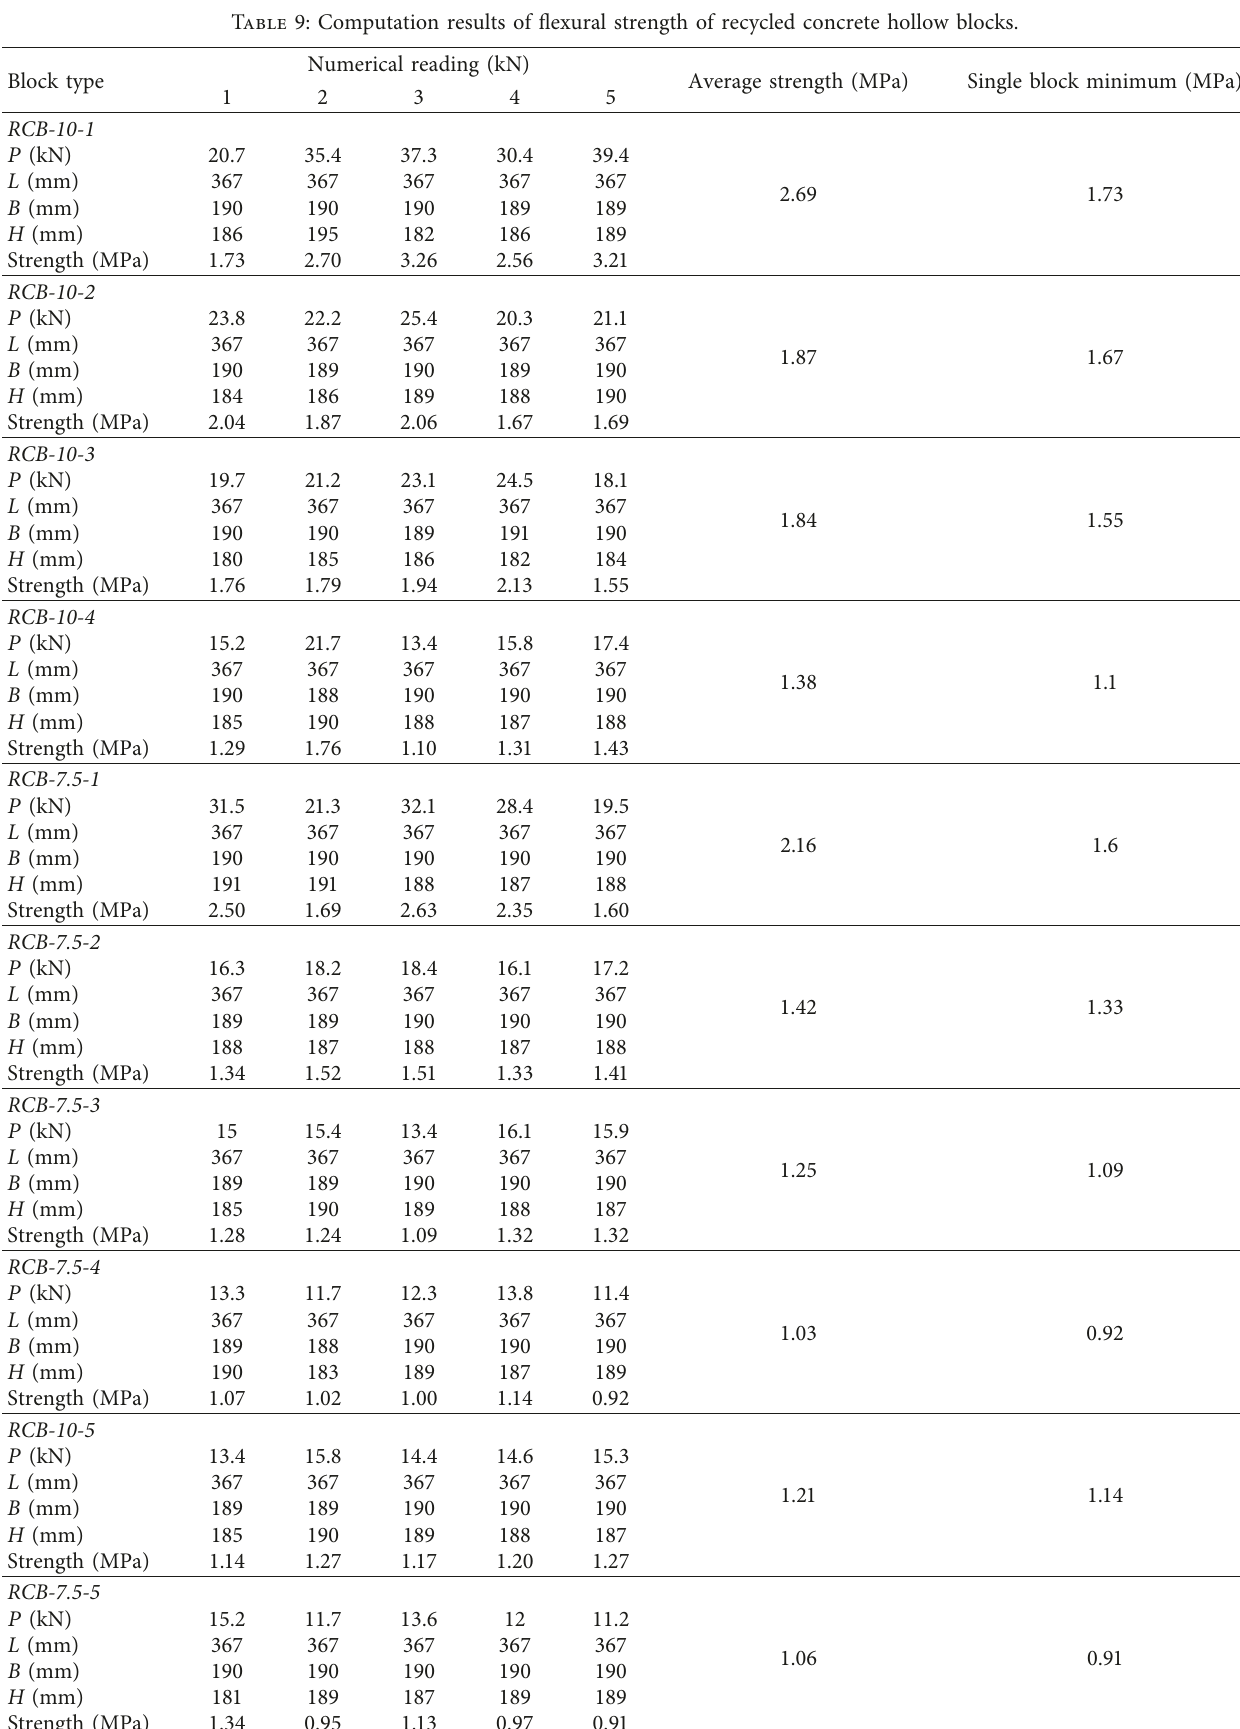
Table 9: Computation results of flexural strength of recycled concrete hollow